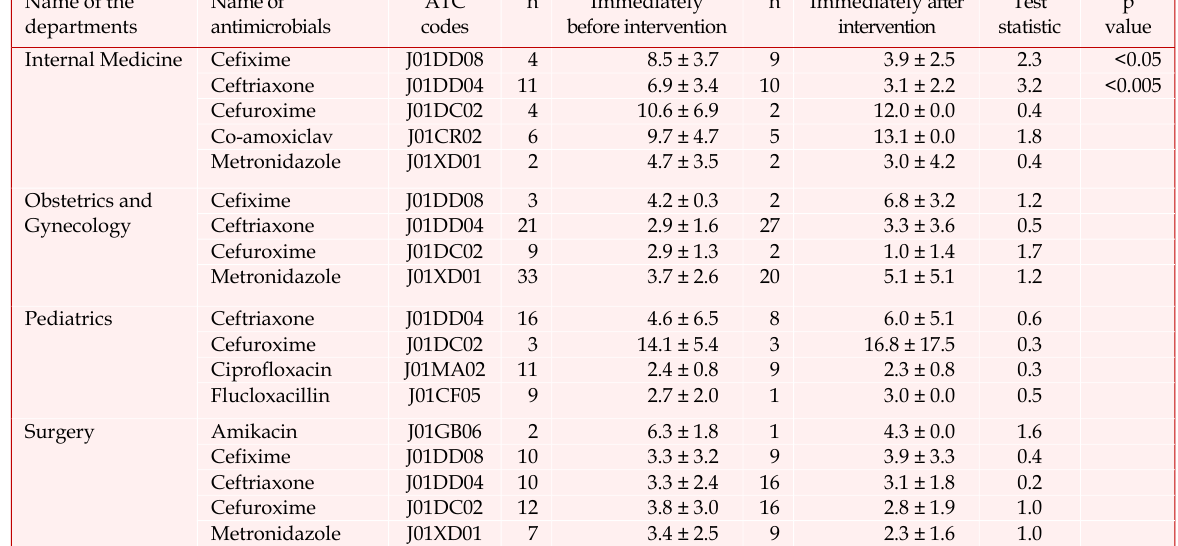
Effect of antimicrobial guideline with ASP on use of individual antimicrobials (expressed in total DDD con- sumed per admitted patient who received